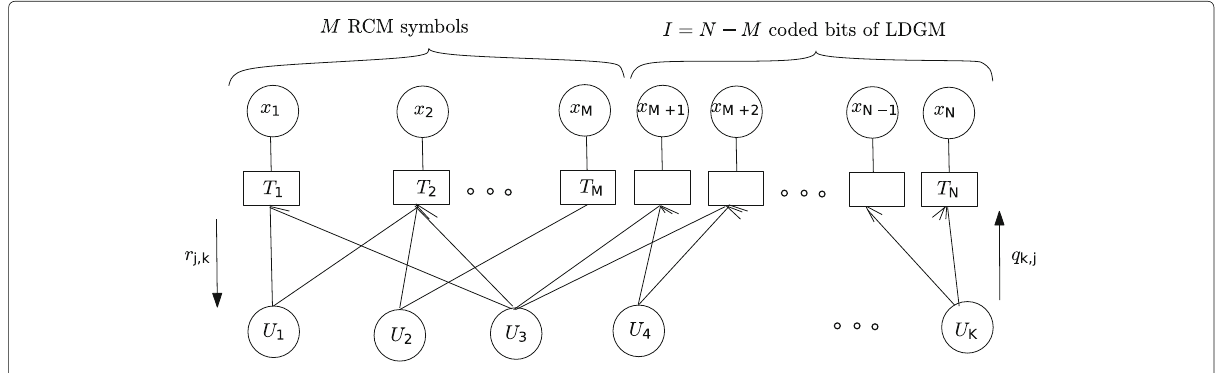
Fig. 1 Factor graph representing the parallel RCM-LDGM